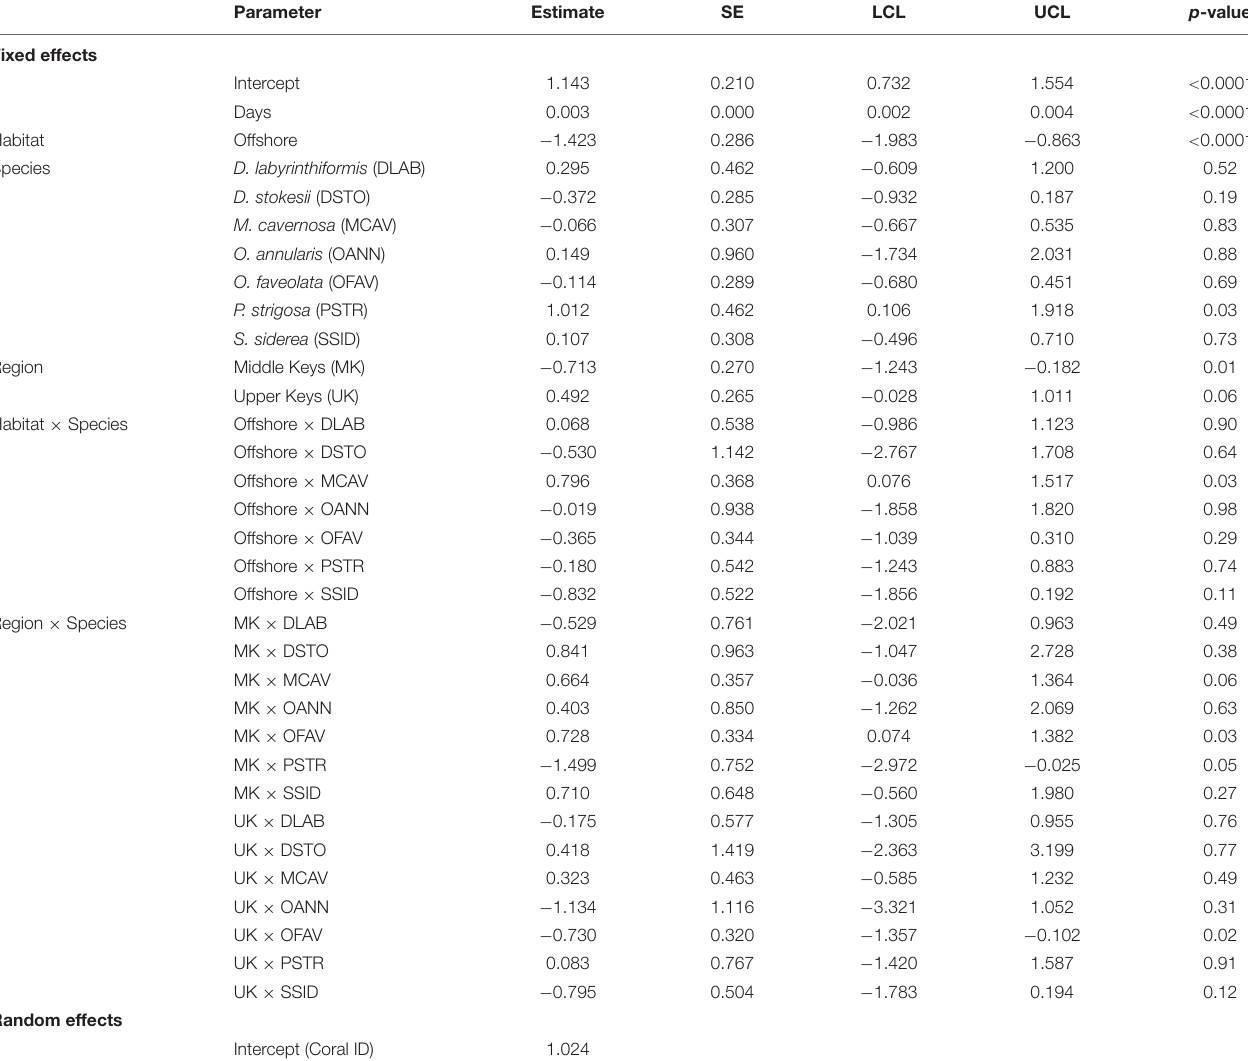
TABLE 5 | Parameter estimates affecting the probability of a colony within the monitoring and touch-up regime being without disease up to 24 months after initial treatment. Parameter